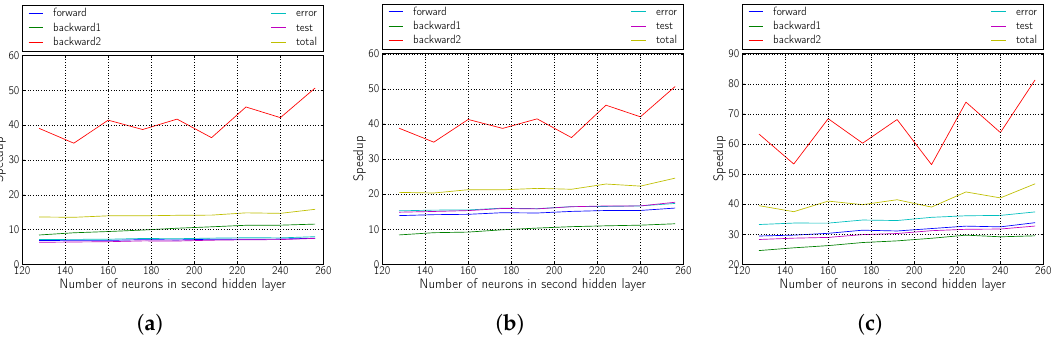
Figure 7. Speedup of the kernel when varying the number of neurons in the second hidden layer. ( a ) Version 1; ( b ) Version 2; ( c ) Version 3.